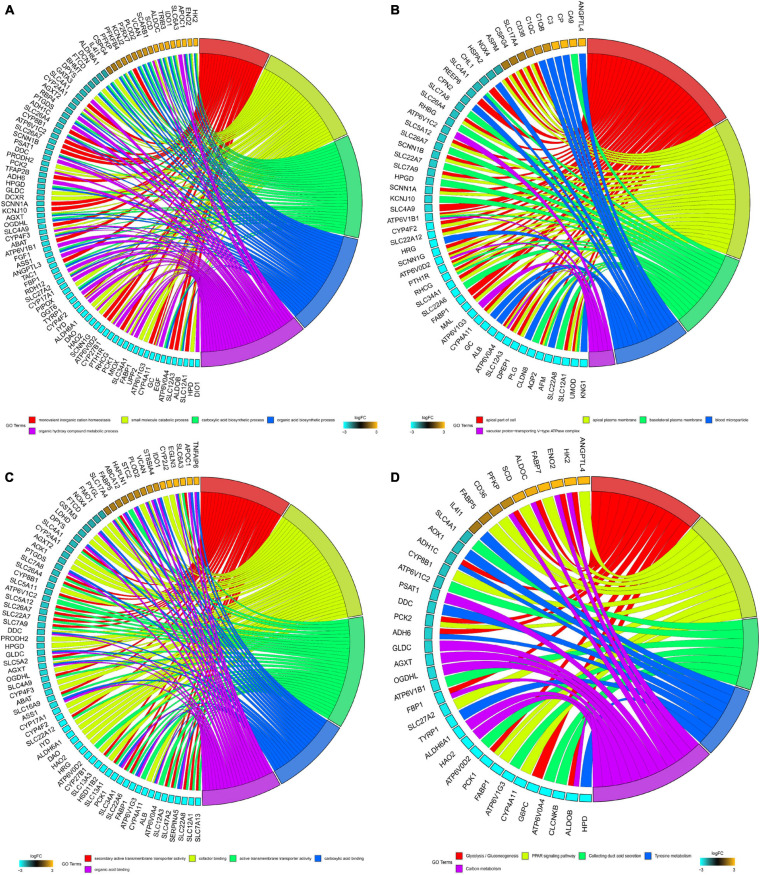
GO and KEGG analysis of robust DEGs. (A) Chord plot shows the relationship between genes and GO terms of biological process. (B) Chord plot shows the relationship between genes and GO terms of cellular component. (C) Chord plot shows the relationship between genes and GO terms of molecular function. (D) Chord plot shows the relationship between genes and KEGG pathways (GO, Gene Ontology; KEGG, Kyoto Encyclopedia of Genes and Genomes).